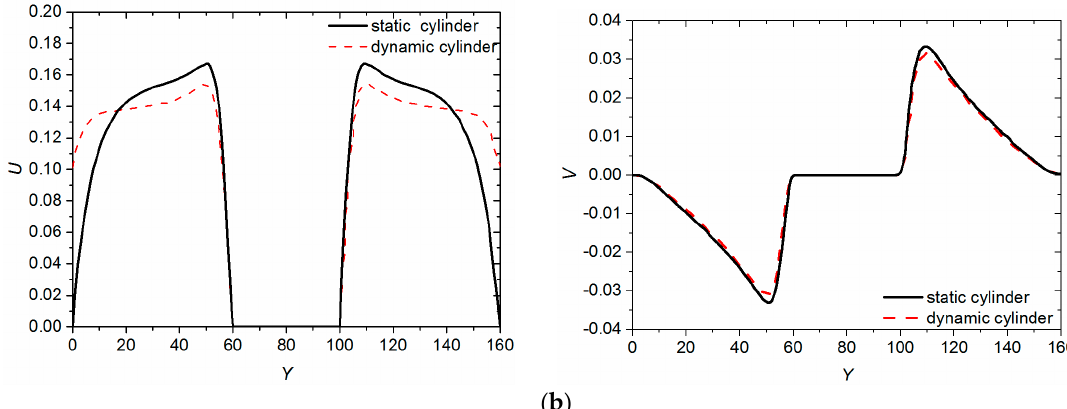
Figure 4. Comparison of numerical results of U and V on cross section and longitudinal section. ( a ) Comparison of U and V on longitudinal section and ( b ) Comparison of U and V on cross section.